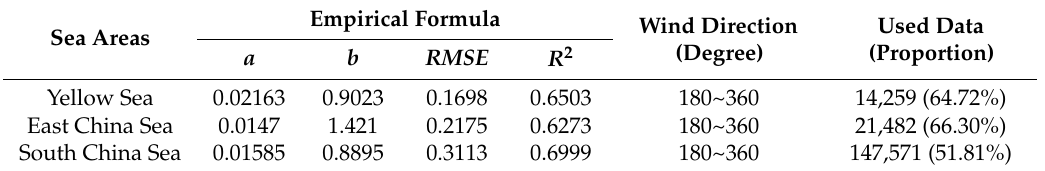
Empirical Formula Wind Direction